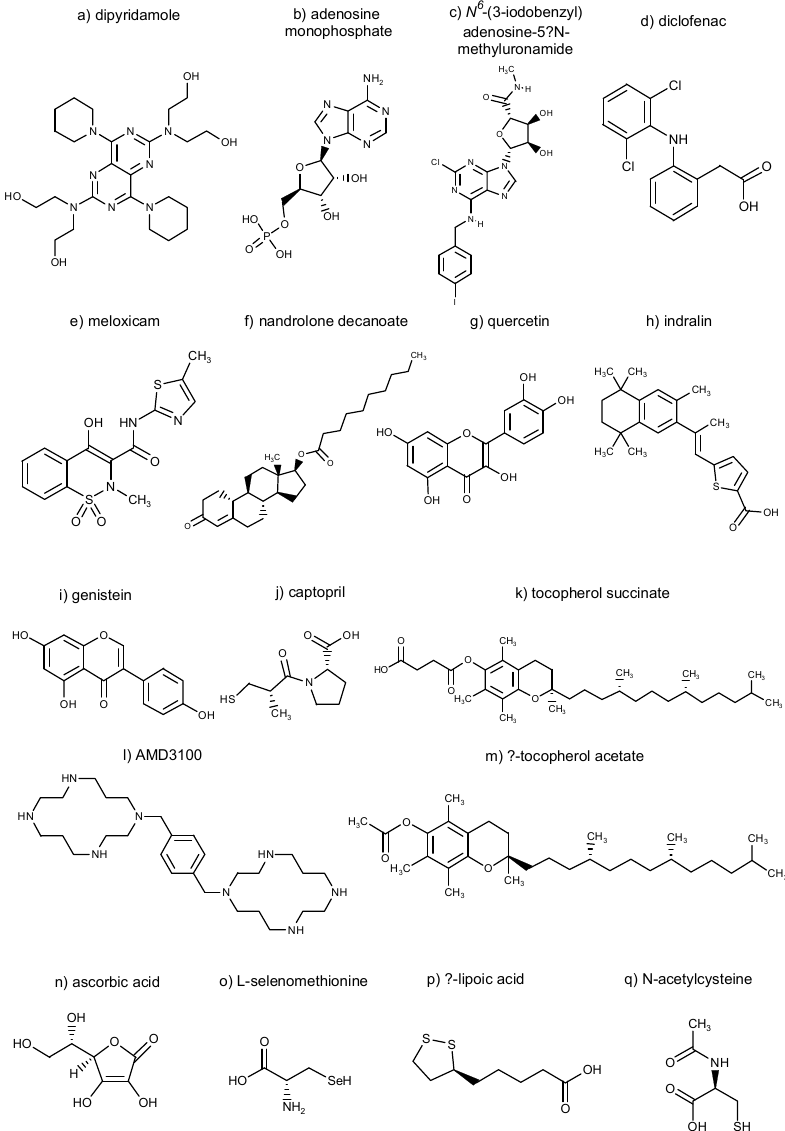
Figure 2. Chemical structures of selected substances explored in Section 3.